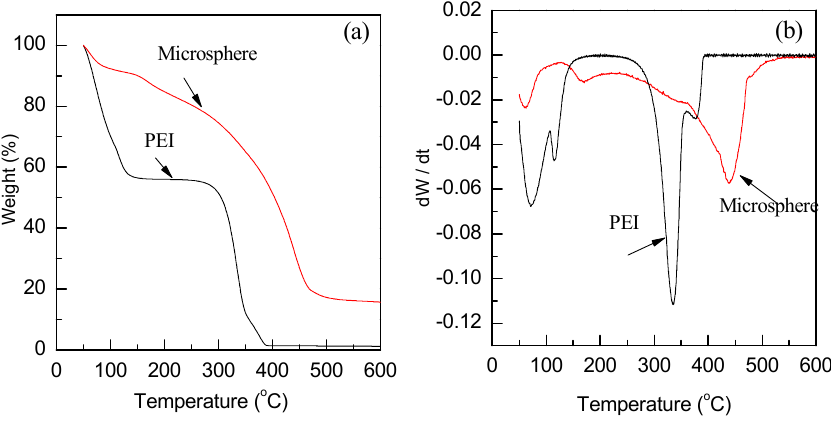
Figure 4. TG ( a ) and DTG ( b ) thermograms of PEI and polyamine